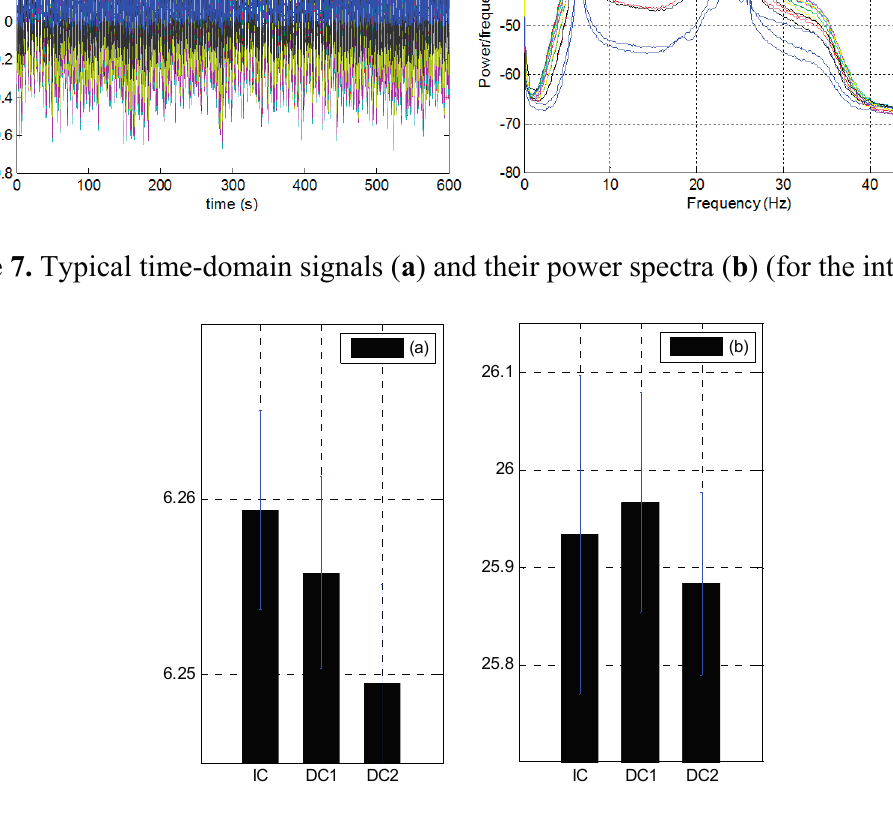
Figure 8. Changes in the natural frequencies and standard deviation owing to damages: ( a ) the first mode and ( b ) the second